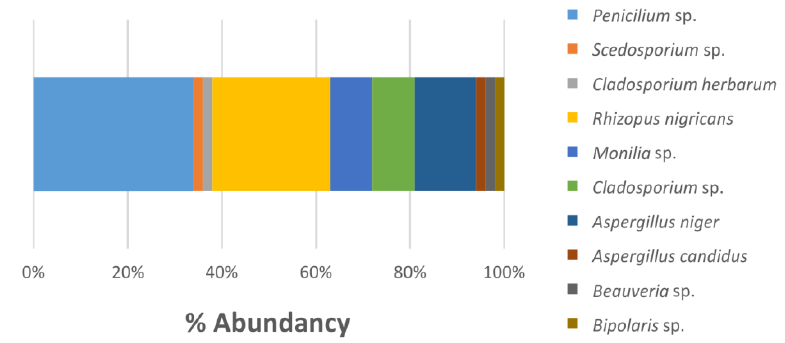
Figure 6. Identification of fungal strains isolated from samples 1A, 2B, 3C and 7G.